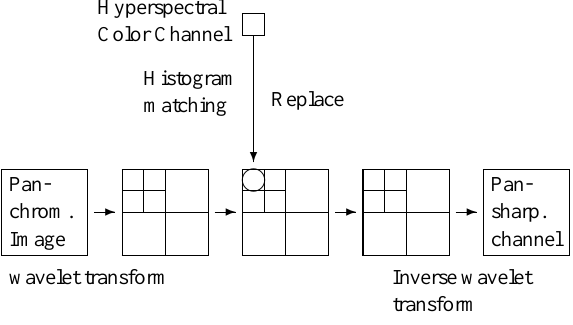
Figure 1: Workflow of Wavelet Fusion according to (Hirschmugl et. al 2005) Different from PCA and Gram-Schmidt Fusion, only local varia- tions of the panchromatic image affect the pansharpening